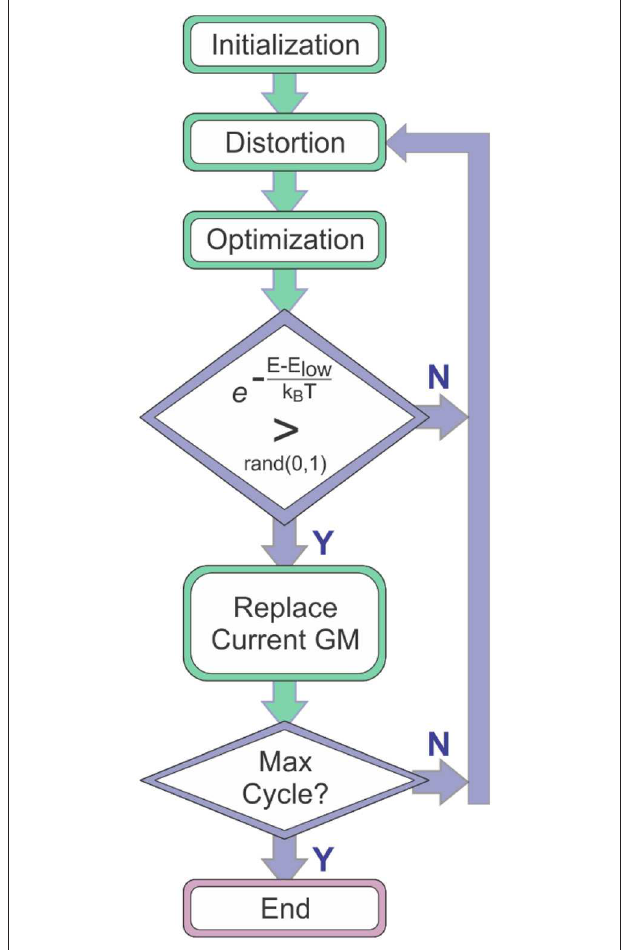
FIGURE 1 | The general procedure of the basin-hopping algorithm. E low is the energy of the lowest energy species identified to that point in the search (i.e., the current global minimum,